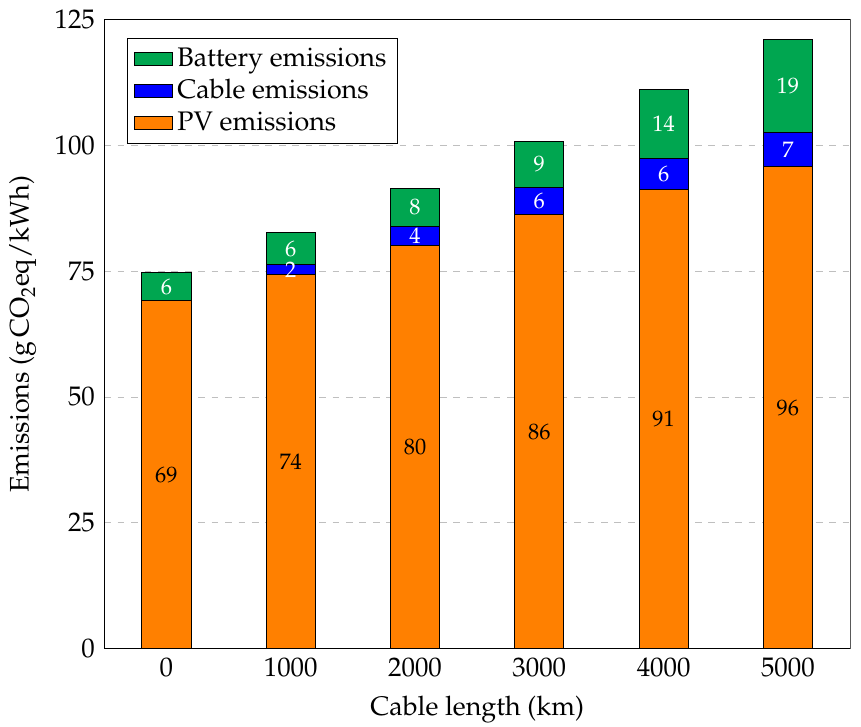
Figure 3. Emissions from production of the battery system, PV installation, and cable per kWh of electricity generated for different cable lengths and reference full-load hours (FLH ref